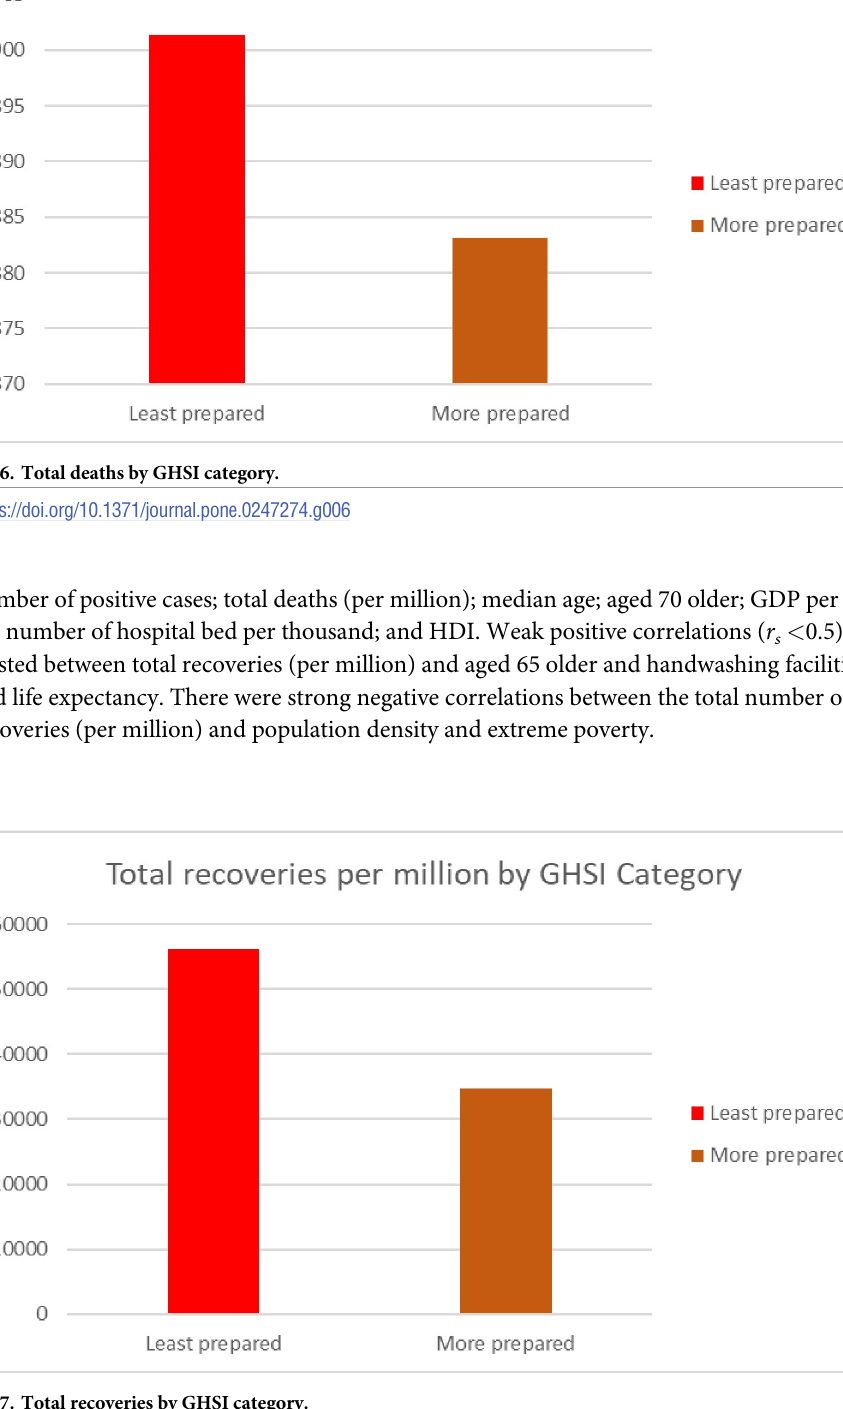
Fig 7. Total recoveries by GHSI